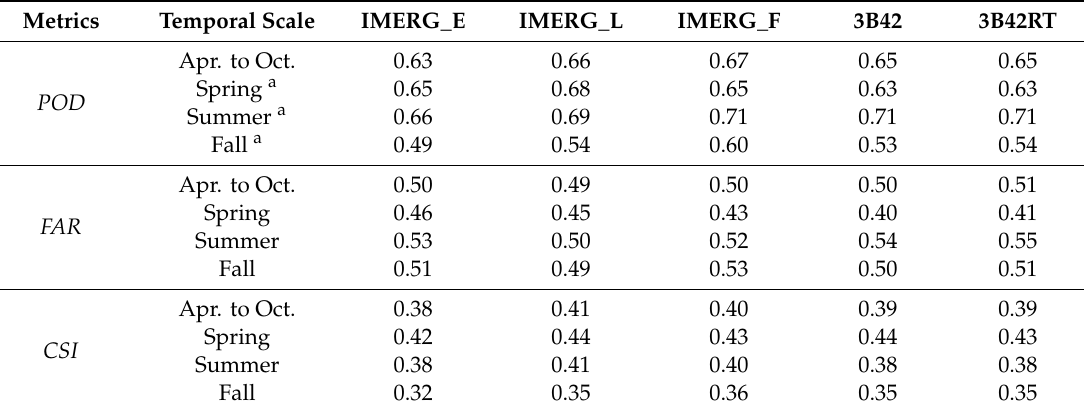
Table 7. Mean categorical evaluation metrics of the SPPs at hourly